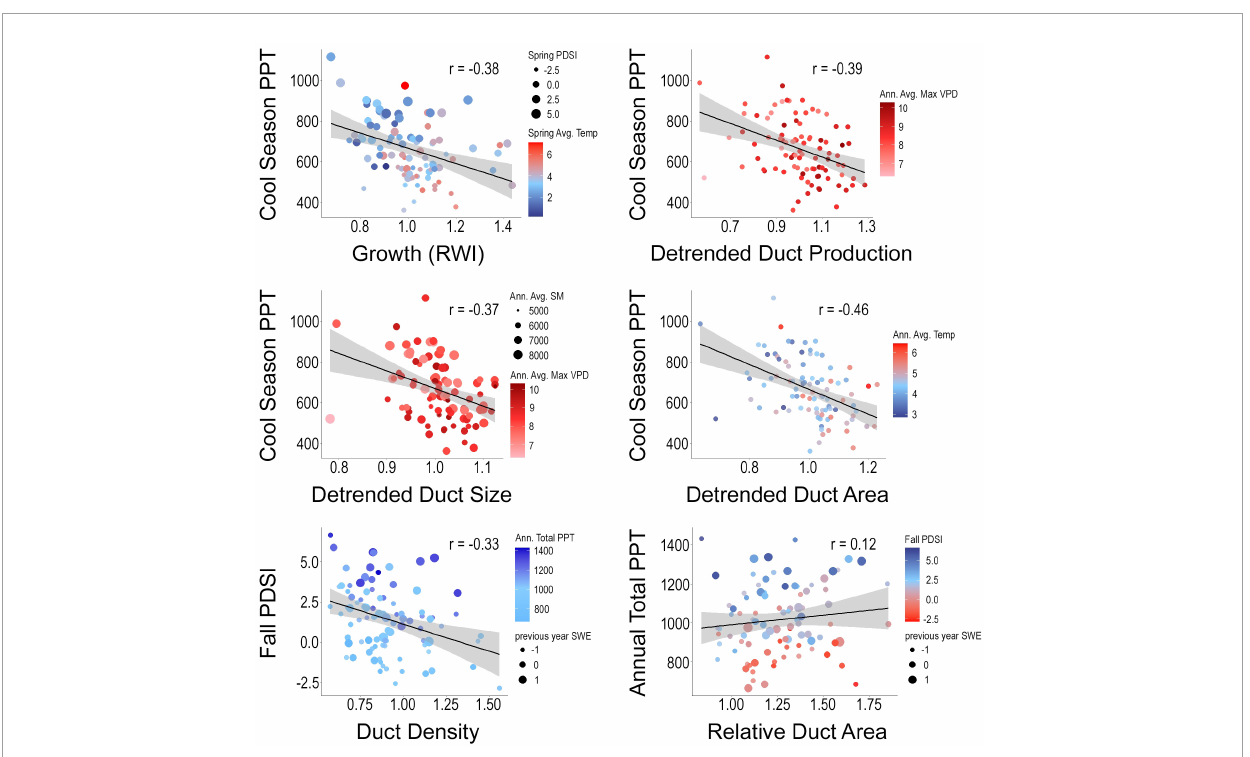
FIGURE4 Scatterplots of whitebark pine tree growth, detrended resin duct production, duct size, and duct area, as well as duct metrics standardized to tree growth (resin duct density and relative duct area) and the primary climate variables derived through the “best” subsets regression framework ( Table 2 ). PDSI, palmer drought severity index; VPD, vapor pressure deficit; SM, soil moisture; PPT, precipitation; SWE, soil-water equivalence; RWI, ring width index.